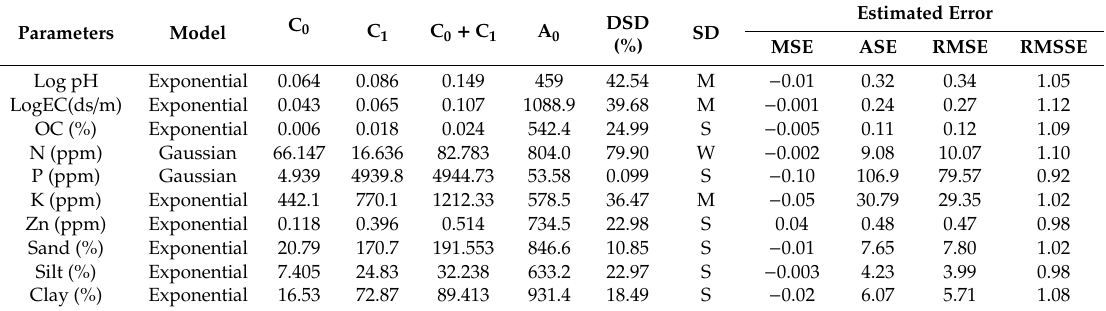
Table 4. Summary of semivariogram parameters of best-fitted theoretical model to predict spatial variability of soil nutrient parameters and cross-validation statistics ( n = 70). Parameters